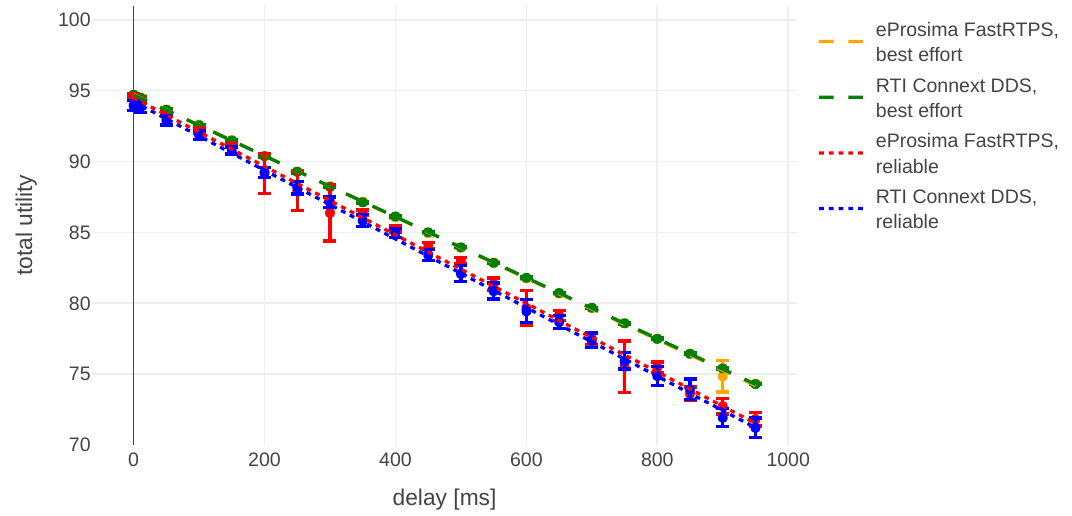
Figure 11. Total utility aggregated during the simulation of the exemplary mission (100 s) for connections with different delays.